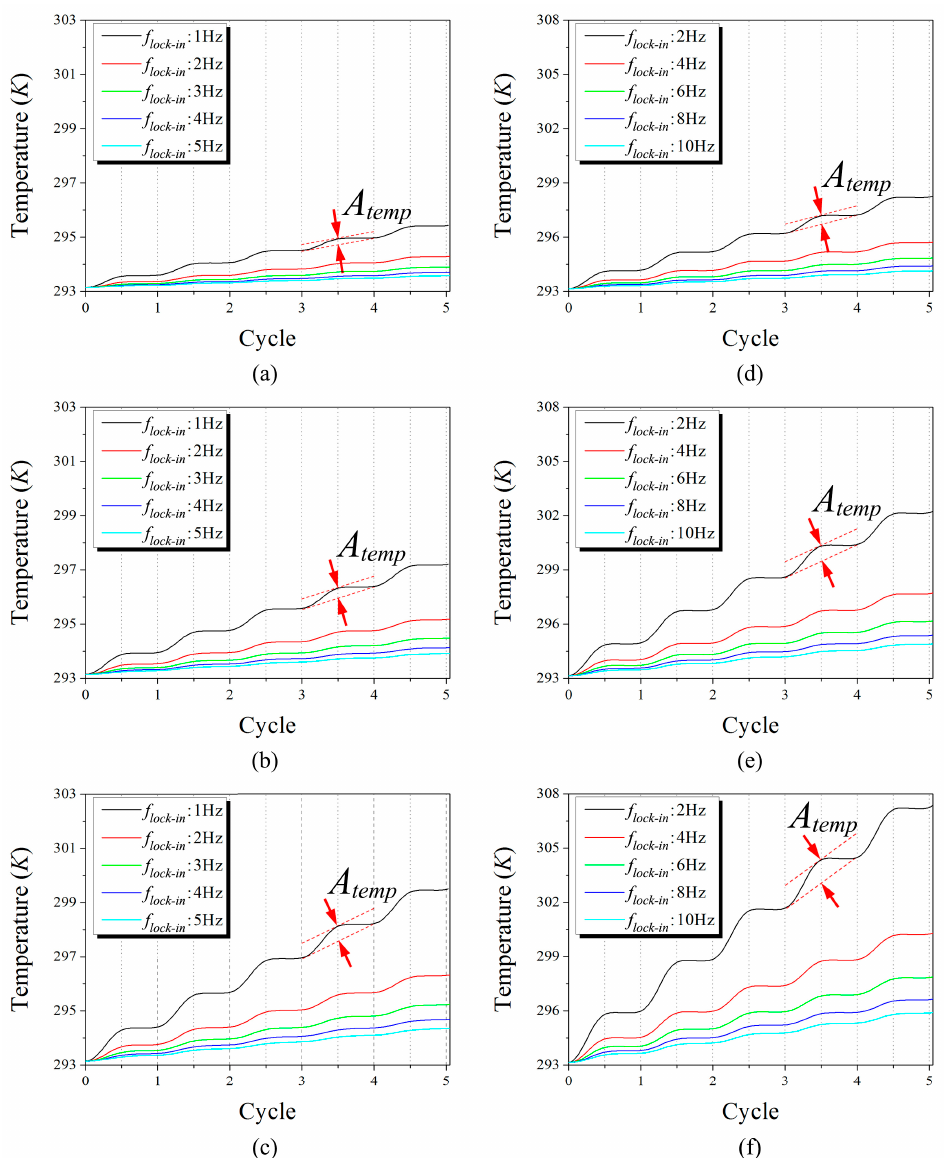
Figure 7. Numerical simulation results on the transient thermal responses for the whole range of lock-in frequencies with different bias voltages, by representing the continuous cycle: ( a ) 3 V biased two-layer SSHSC; ( b ) 4 V biased two-layer SSHSC; ( c ) 5 V biased two-layer SSHSC; ( d ) 3 V biased three-layer SSHSC; ( e ) 4 V biased three-layer SSHSC; ( f ) 5 V biased three-layer SSHSC.